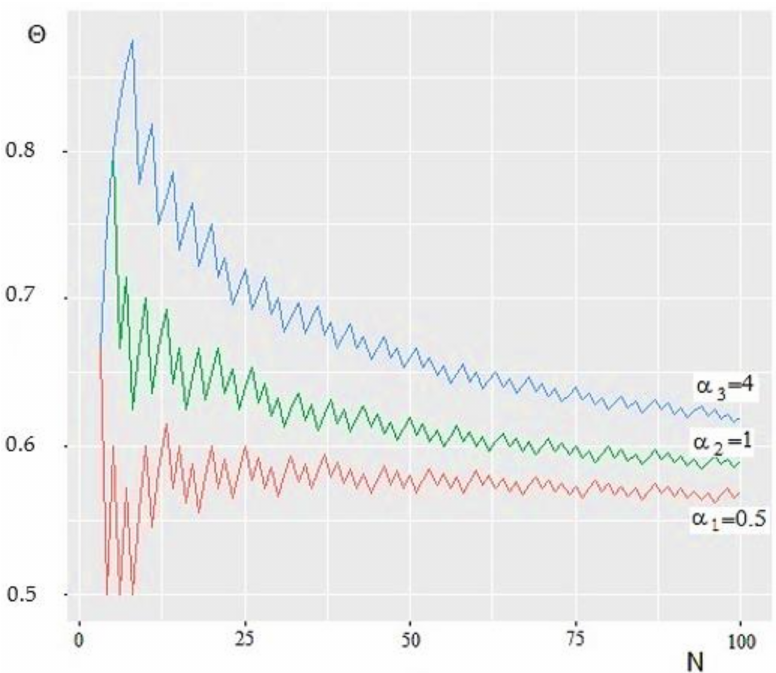
Figure 9. Simulation of the optimal number of m vehicles for the value α 1 = 0.5, α 2 = 1, and α 3 =